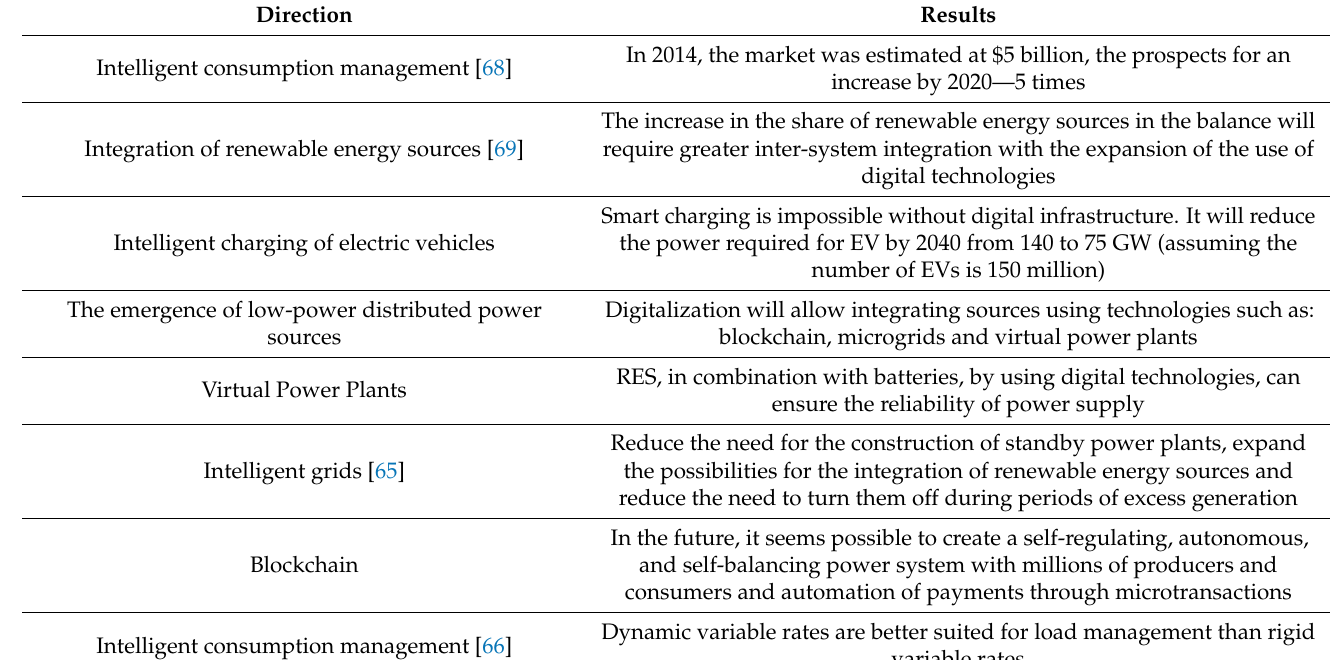
Table 10. Table of results of digitalization in the energy sector (developed by the